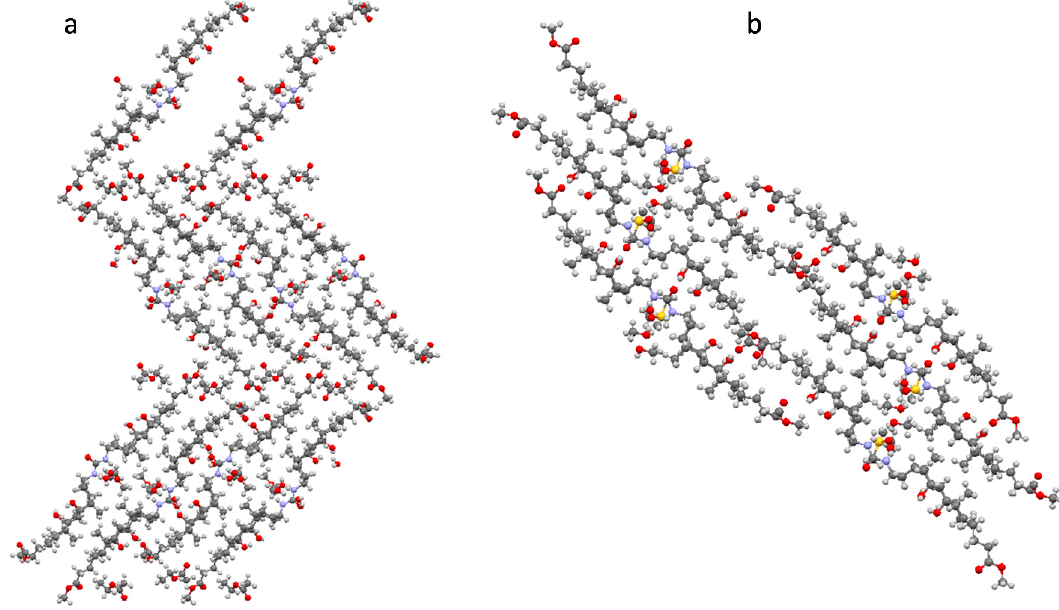
Figure 1. View of the molecular packing along the a axis ( a ) in the crystal of 30/AcOEt and ( b ) along the b axis in the crystal of 30/DMSO.